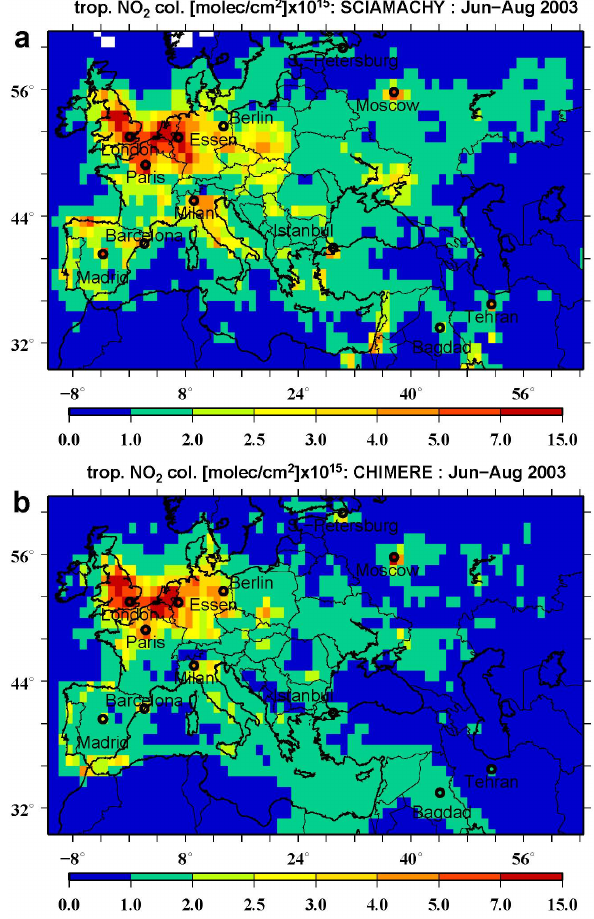
Fig. 2. Tropospheric NO 2 columns derived from SCIAMACHY measurements (a) in comparison with the corresponding NO 2 columns simulated by CHIMERE (b) . The data shown are averages over three summer months of 2003.